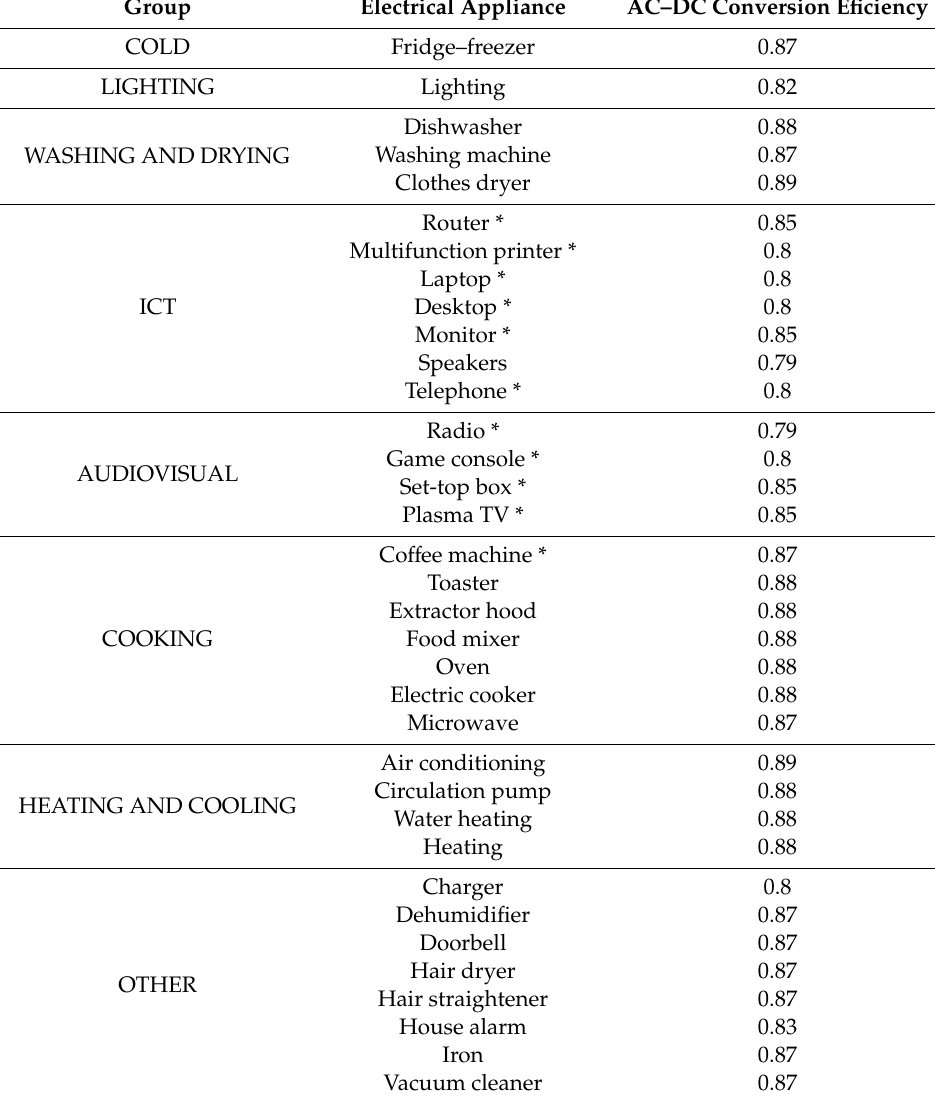
Table 1. Electrical appliances with their conversion e ffi ciencies divided by